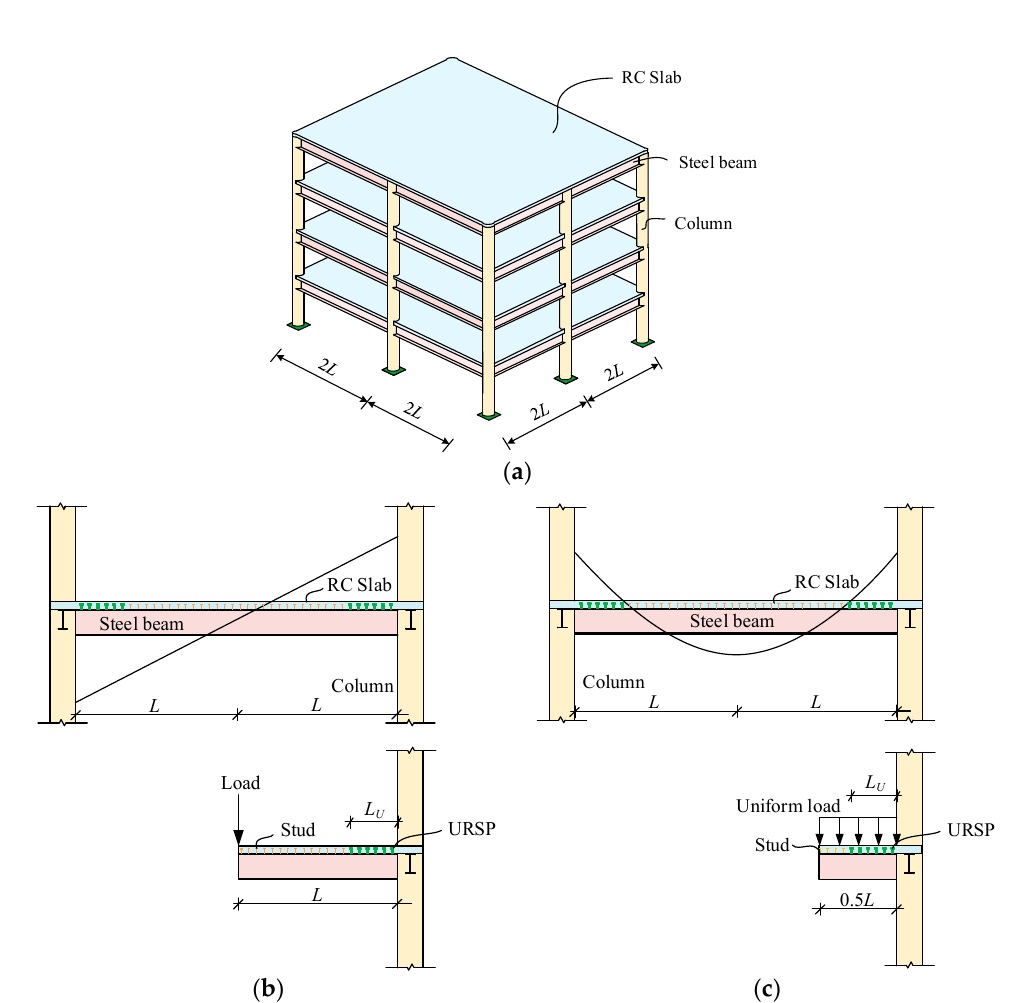
Figure 3. Two load cases simplified from a typical frame structure. ( a ) Typical steel-concrete composite frame structure; ( b ) Load case 1; ( c ) Load case 2.